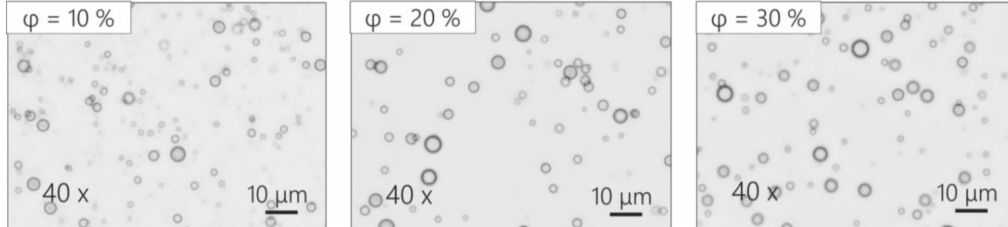
Figure 3. Micrographs for water-in-crude oil (w/o) emulsions. Aqueous phase contents ( ϕ ) are shown in the